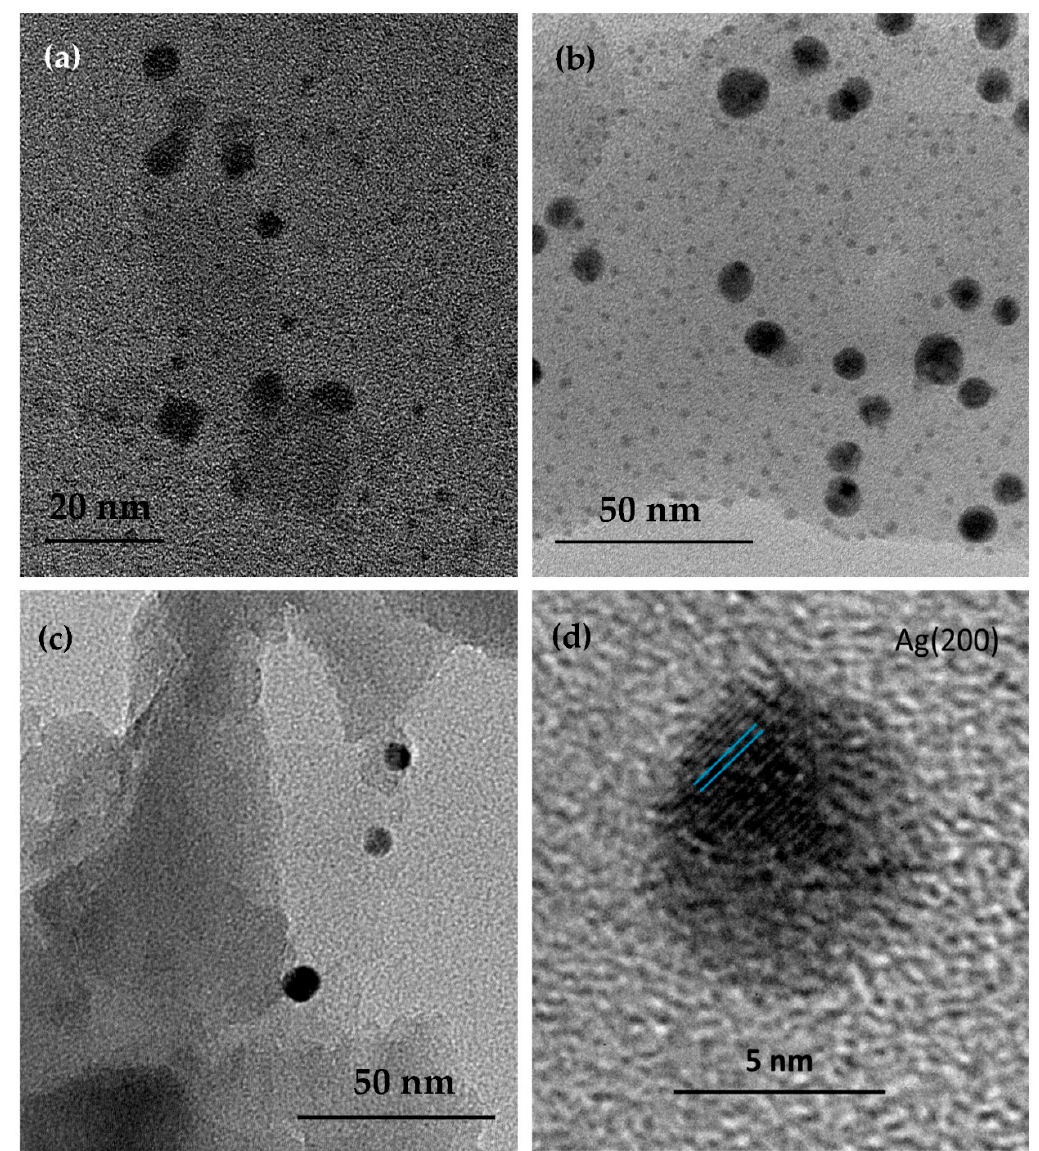
Figure 2. TEM images at high magnification of silver–zeolite composites: ( a ) Ag–Zeo, ( b ) Ag–NaZeo, ( c ) Ag–HZeo, ( d ) HRTEM of AgNP.